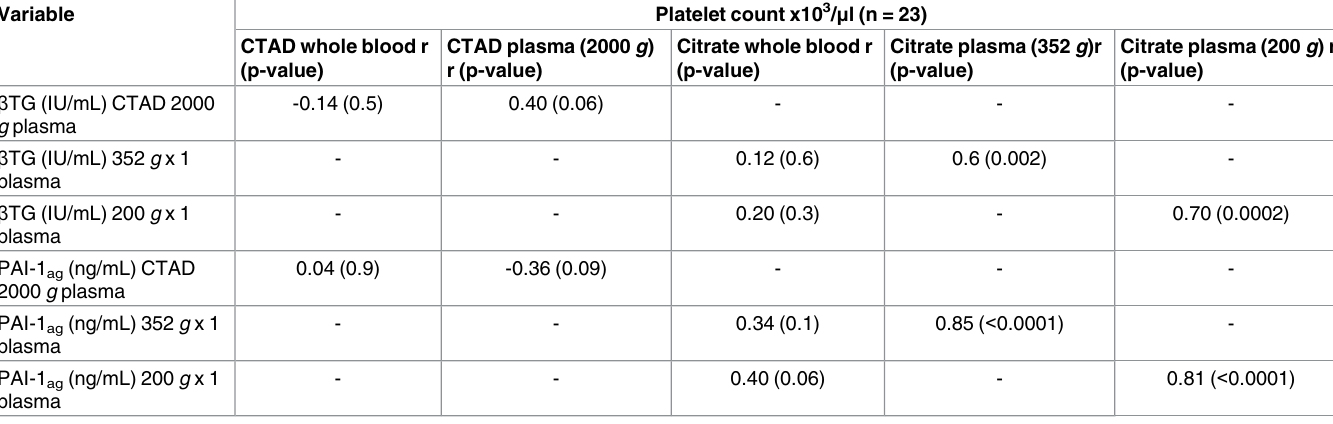
Table 5. Spearman rank order correlations of β TG and PAI-1 ag with whole blood, CTAD and citrate plasma platelet count of the follow-up study. Variable